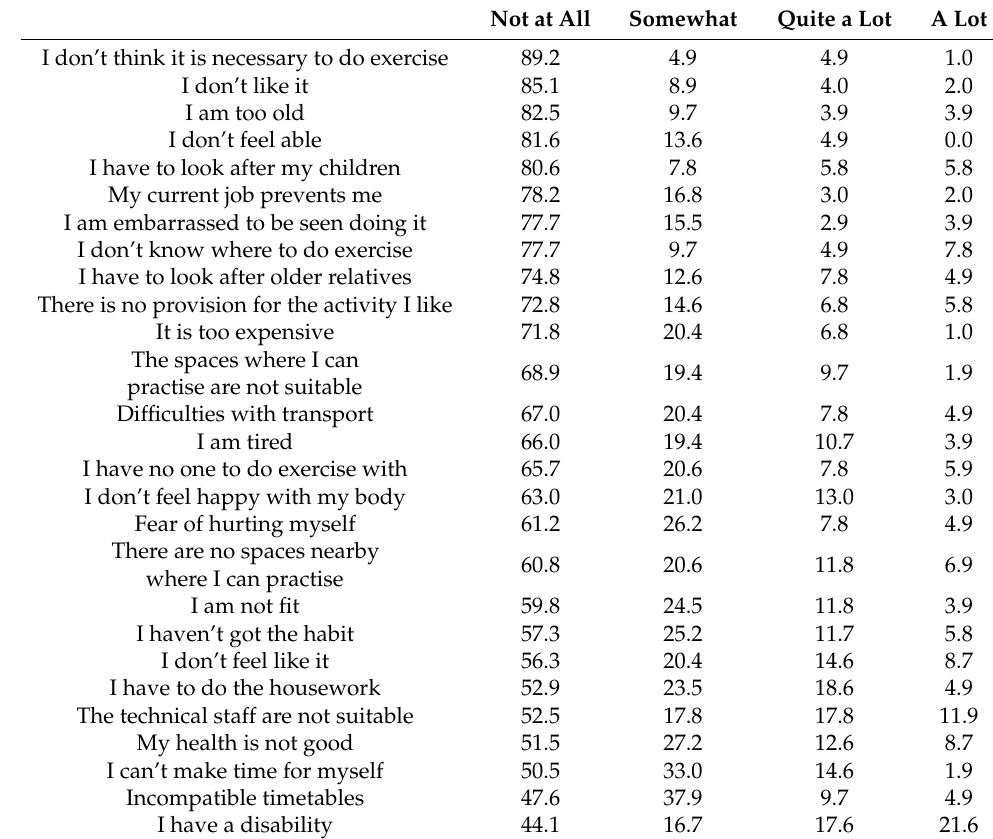
Table 1. Results (%) referring to the barriers to the practice of physical activity and sport perceived by all the participants in the study.